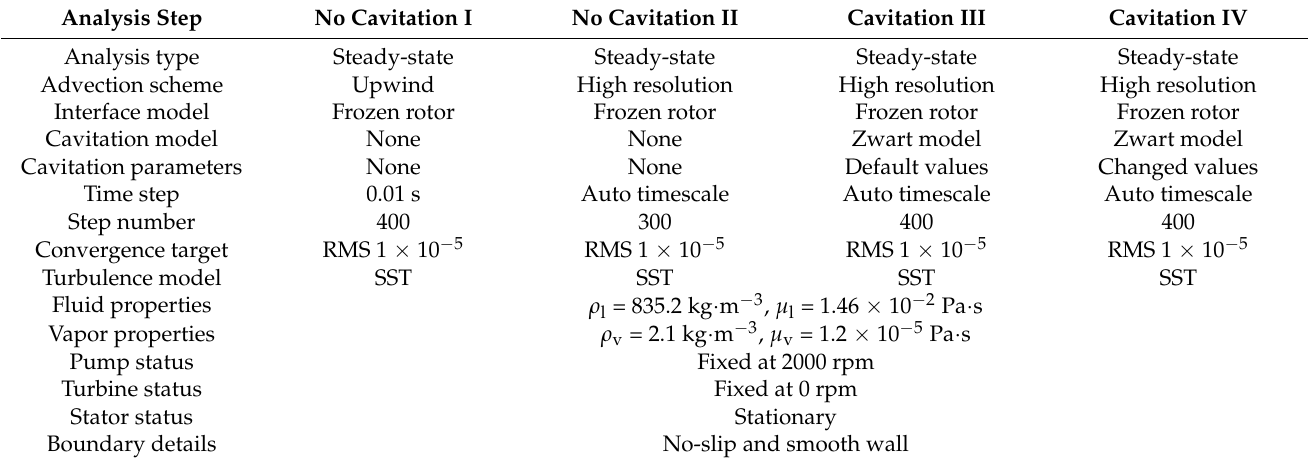
Table 2. Detailed setting of torque converter CFD